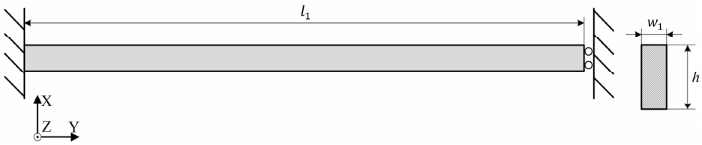
Figure 5. The schematic diaphragm of the supporting beam.